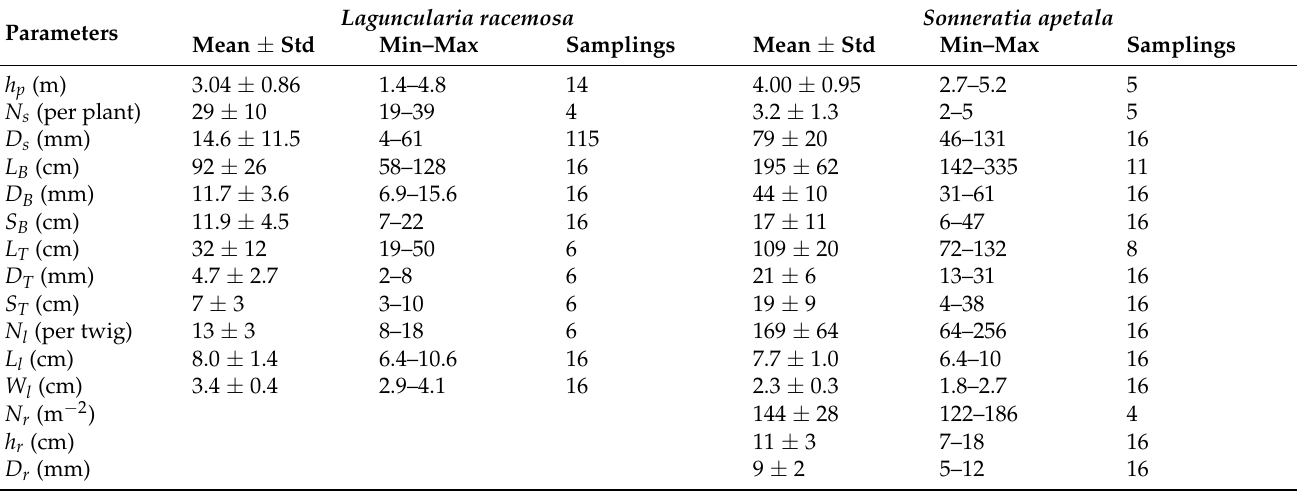
Table 1. Measured plant properties, h p is the plant height, N s is the number of stems for one plant. D , L , and W are the diameter, length, and width of the plant element, respectively, with the subscript s , B , T , l , and r denoting the stem, branch, twig, leaf, and root (pneumatophore), respectively, S denote the space between two neighbor elements. N l is the number of leaves on one twig (e.g., shown in Figure 2b-2). N r is the density of